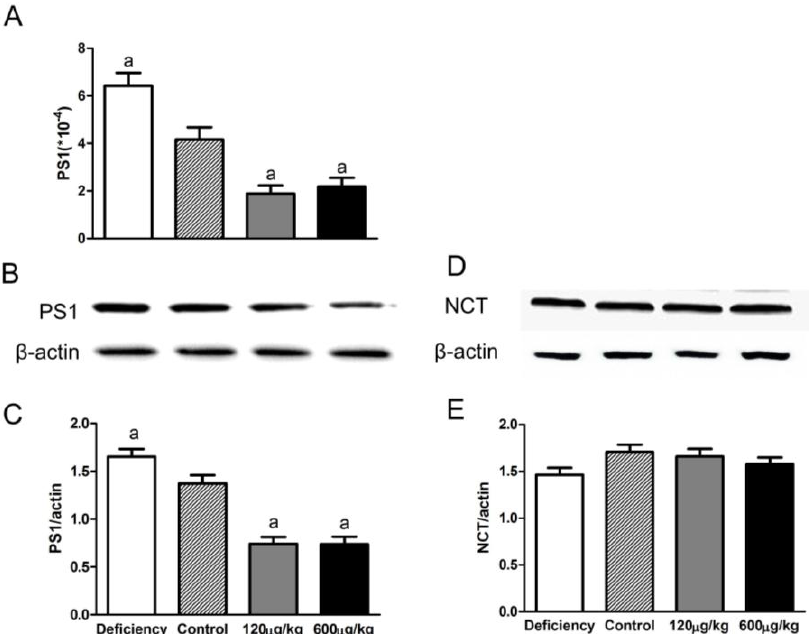
Figure 4. Folate inhibited PS1 expression, but not NCT (nicastrin), in APP/PS1 mice. PS1 mRNAs and proteins in the brains of APP/PS1 mice were determined by qRT-PCR and Western blot analysis. Folic acid treatment inhibited PS1 mRNA and protein expression. Folate deficiency led to up-regulation of PS1. No difference in PS1 expression was showed between 120 μg/kg and 600 μg/kg groups ( A – C ); However, Western blot analysis revealed that folic acid did not change NCT protein levels ( D , E ). The data were expressed as means ± SD values, n = 6 animals/group. a: p < 0.05 versus the Control group.